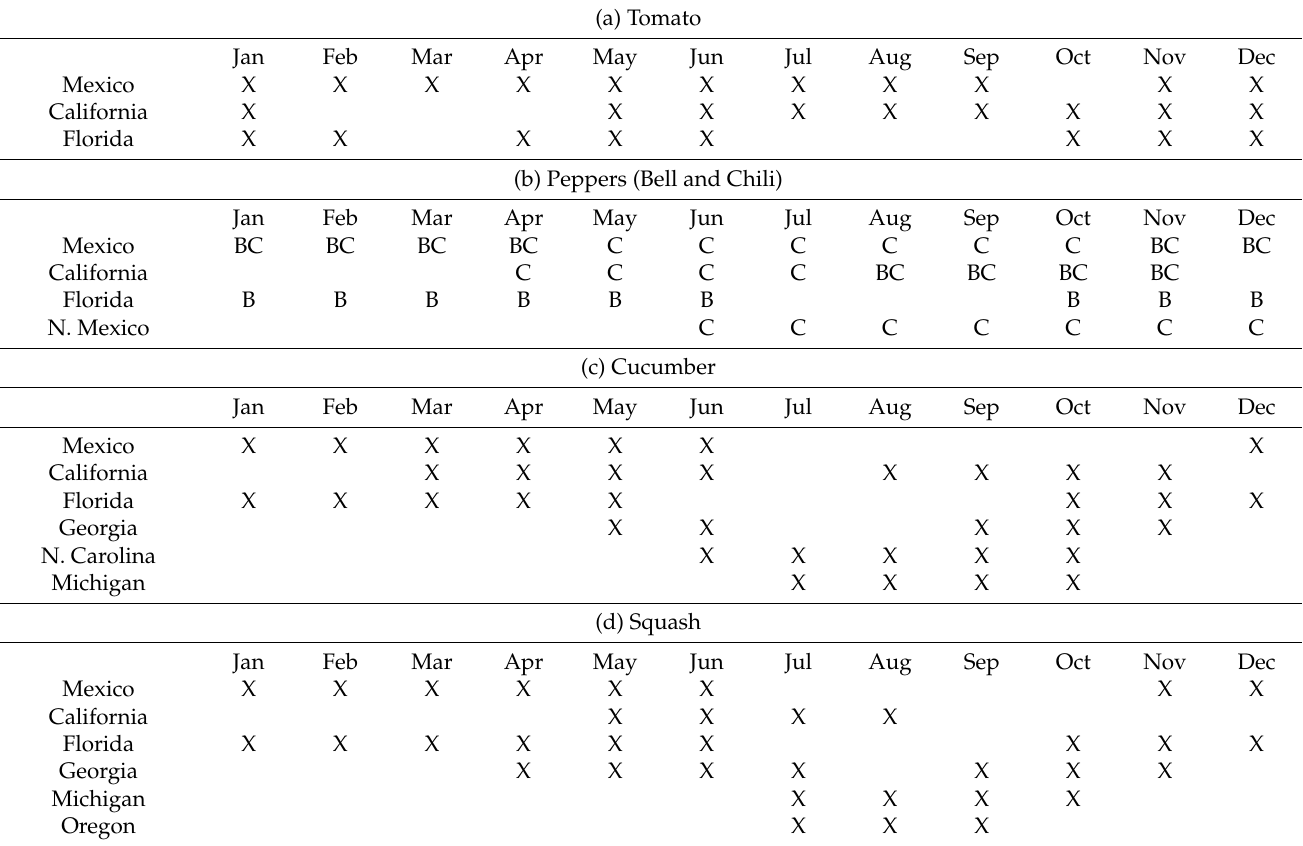
Table A2. Vegetables harvesting calendars of major U.S. producing states and